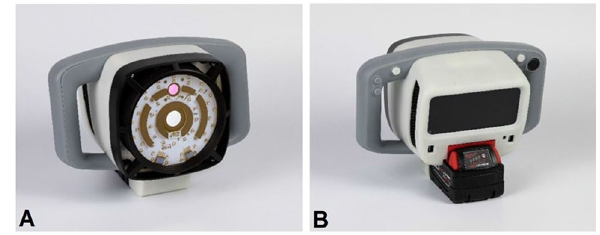
Figure 1. CSI-D device. ( A ) Front view. ( B ) Rear